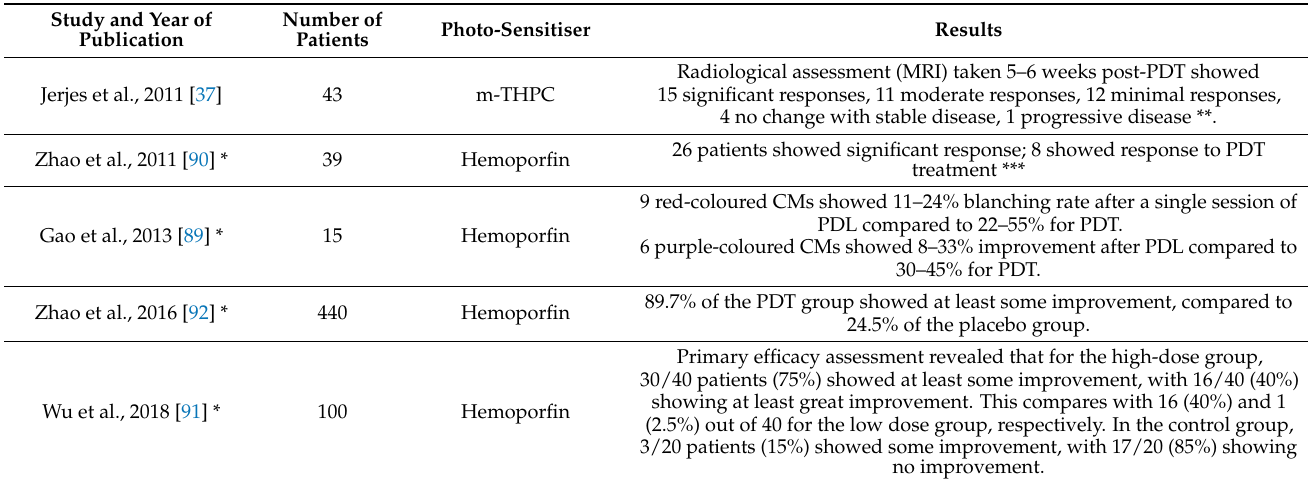
Table 5. Summary of recent clinical trials evaluating the efficacy of PDT in the treatment of vascular anomalies. Study and Year of